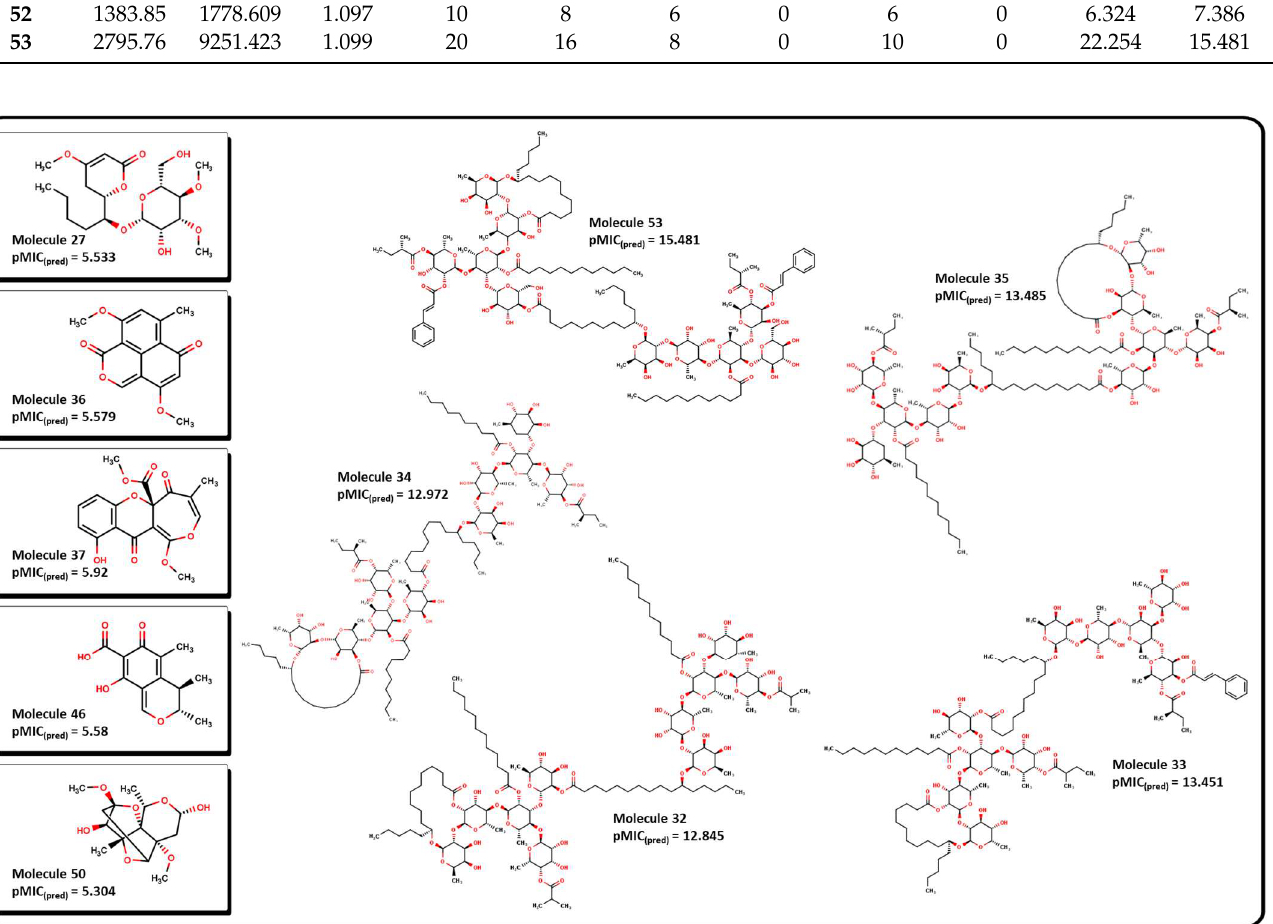
Figure 14. Molecular structure of selected natural products. Molecules 32 to 35 and 53 exhibits the highest predicted p MIC value. Molecules 27 , 36 , 37 , 46 , and 50 show low predicted values according to Equation (12). Table 1. Molecular descriptor values for natural products 26 to 53 with their predicted p MIC value. These molecules show the highest values from the BIOFACQUIM database.